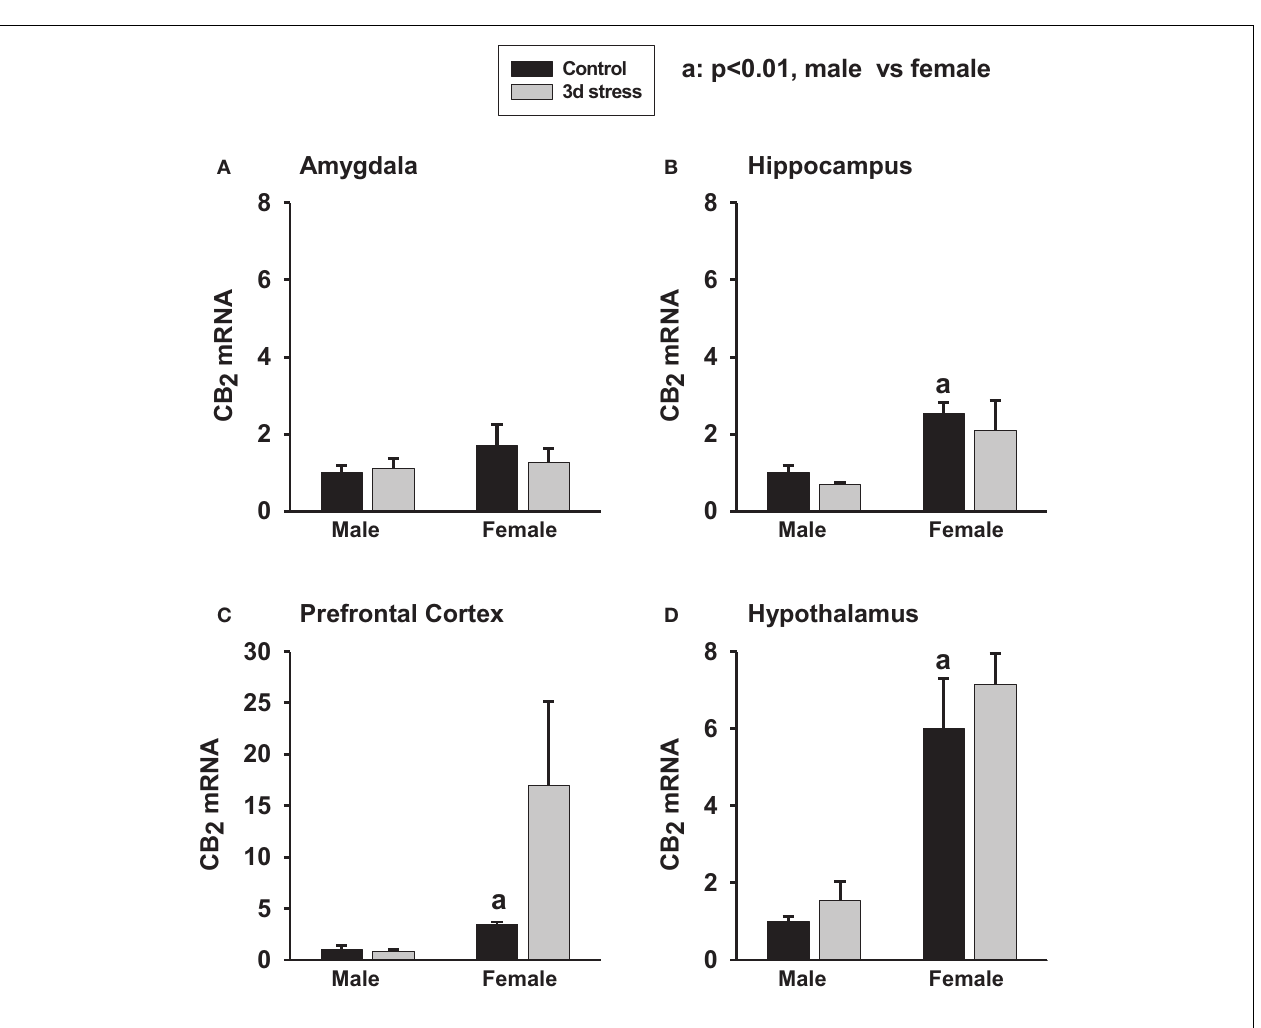
mRNA levels were significantly increased in the prefrontal cortex of female rats after the stress exposure ( p < 0.05). Black column: control; gray column, stressed group, a, p < 0.01, male control vs. female control; * p < 0.05; ** p < 0.01, control vs. stress within sex